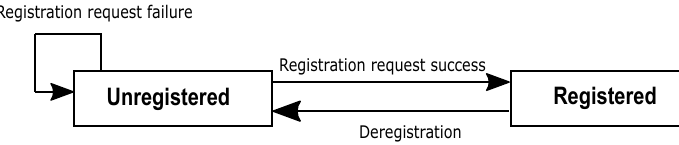
Figure 3. CBSD registration state